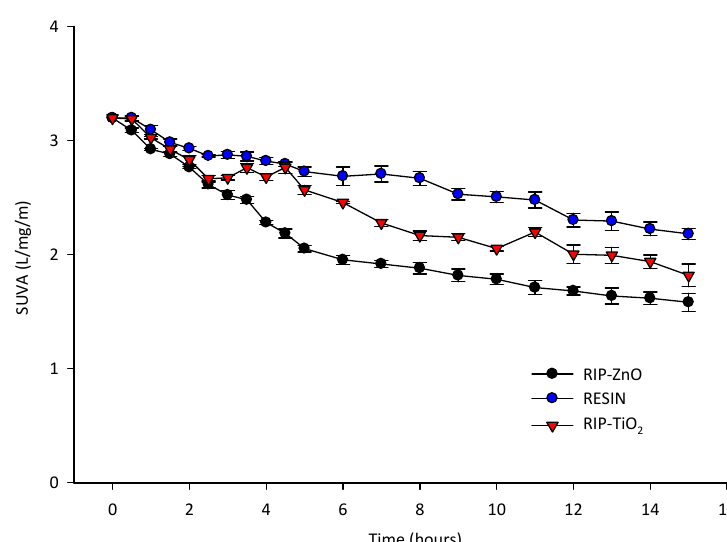
Fig. 3: The changing of SUVA value in tofu wastewater under various processes of resin, RIP‐TiO 2 , and RIP‐ZnO